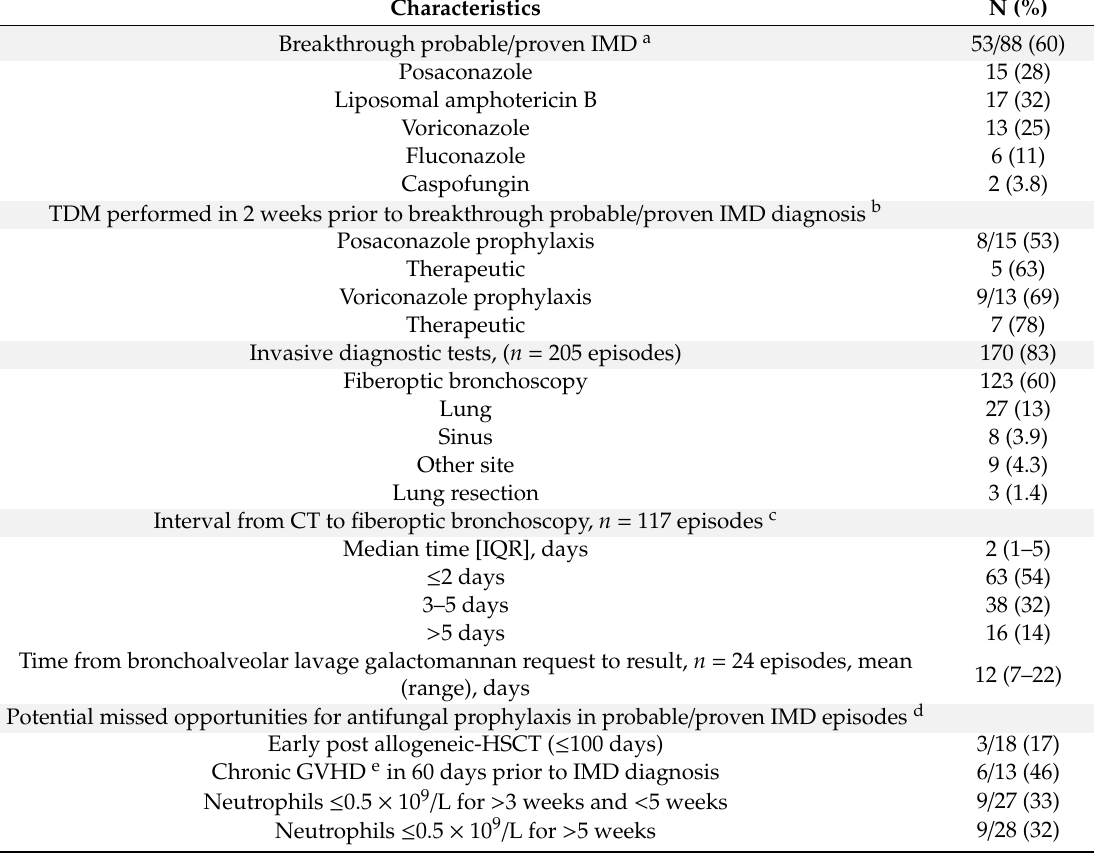
Table 3. Gaps and opportunities for antifungal